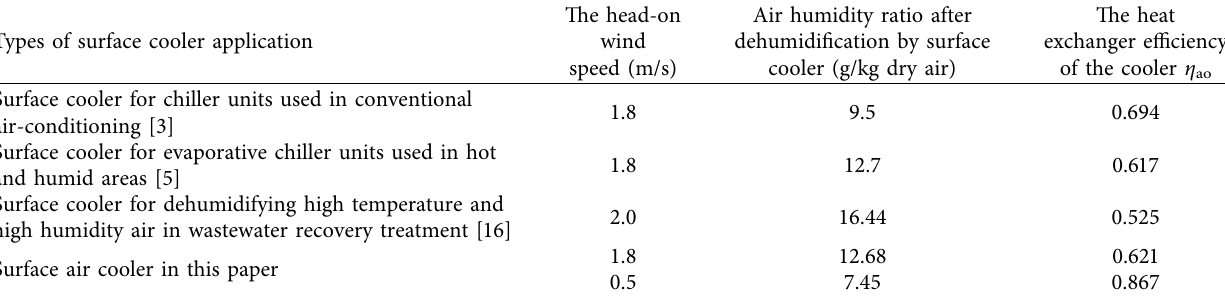
Table 3: Comparison of surface coolers in different